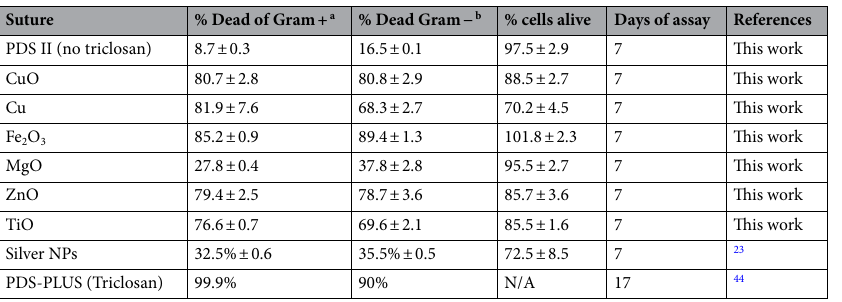
Table 2. Comparative antibacterial effect and cytotoxicity of different nanoparticles and the standard triclosan coated suture (PDS PLUS). a Gram-Positive: S. aureus. b Gram-Negative: P. aeruginosa (this work), E. Coli (other works).